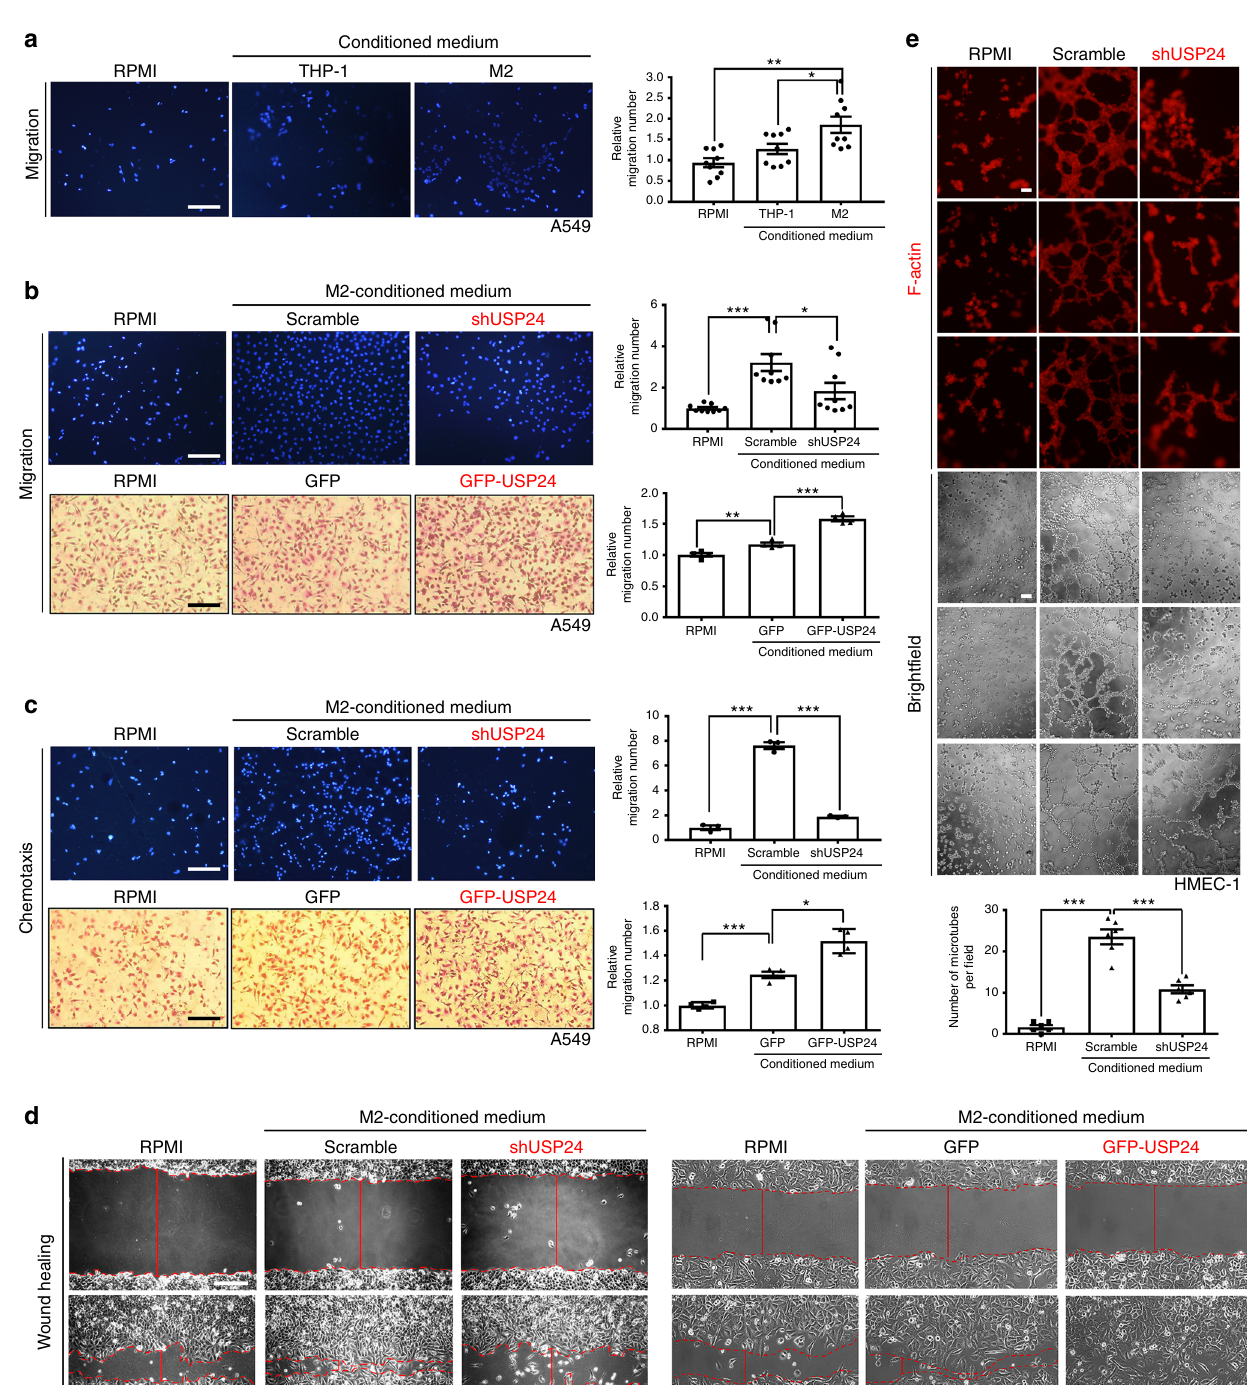
Fig. 2 The metastasis-related effects of conditioned medium derived from M2 macrophages. a A549 cells were treated with RPMI or conditioned medium derived from THP-1 or M2 macrophages for 24 h, and transwell migration assay was performed to analyze the migratory ability of lung cancer cells (DAPI staining, n = 9). Scale bar represents 60 μ m. b – d A549 cells were treated with RPMI or conditioned medium derived from USP24 knockdown or USP24 overexpression M2 macrophages for 24 h, and transwell migration assay ( b ) (DAPI staining, n = 9, scale bar: 100 μ m; Giemsa staining, n = 4, scale bar: 60 μ m), chemotactic assay ( c ) (DAPI staining, n = 3, scale bar: 100 μ m; Giemsa staining, n = 4, scale bar: 60 μ m) and wound-healing migration assay ( d ) were performed. Wound edges were indicated with red dashed lines and wound width was presented as solid red lines. Scale bar represents 200 μ m. e HMEC-1 cells were treated with RPMI or conditioned medium derived from scramble- or USP24-knockdown M2 macrophages for 6 h. Cells were stained with F-actin and photographed ( n = 6). Results were normalized with control and expressed as fold of control. Scale bar represents 200 μ m. Data are shown as mean ± SEM, two-tailed unpaired Student ’ s t -test, * P < 0.05, ** P < 0.01, and *** P <